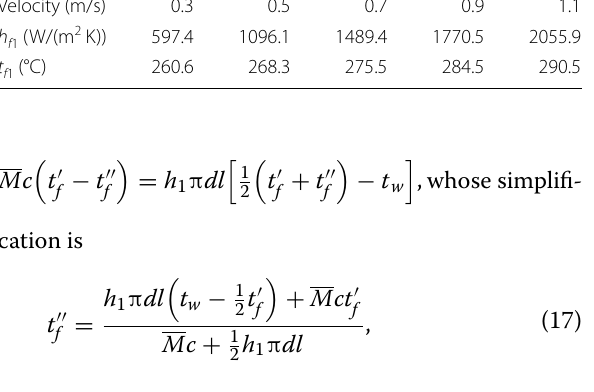
Table 2 Heat transfer coefficient and the average fluid temperature of the respective velocities after calculation Velocity